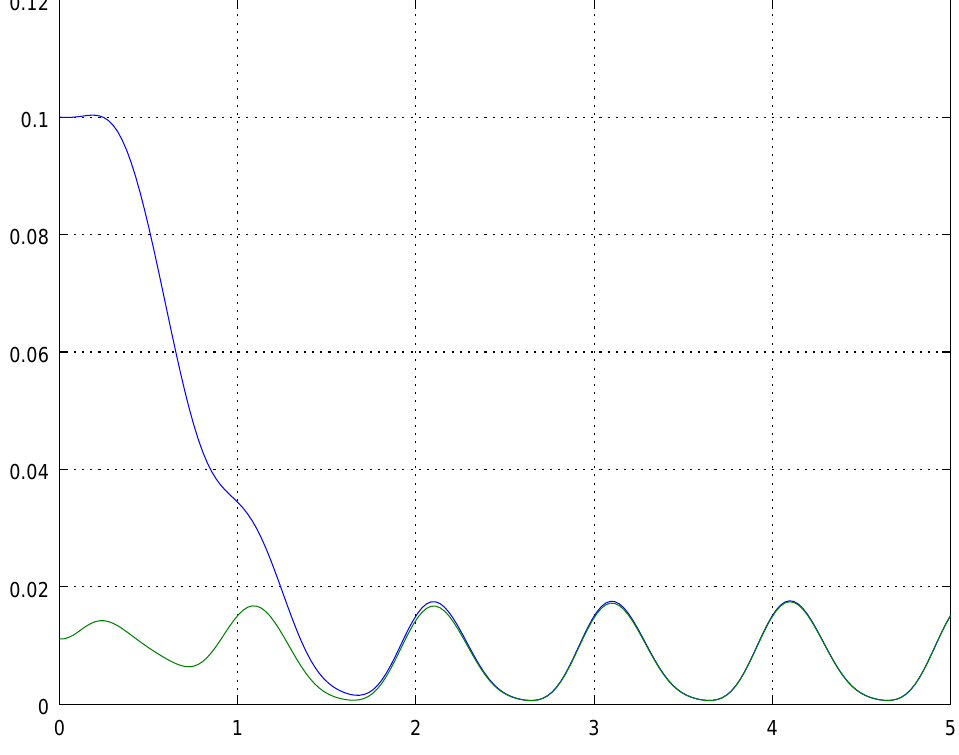
Figure 3. Pr ( X 1 ( t ) = 2 ) under initial conditions (i) and (ii).